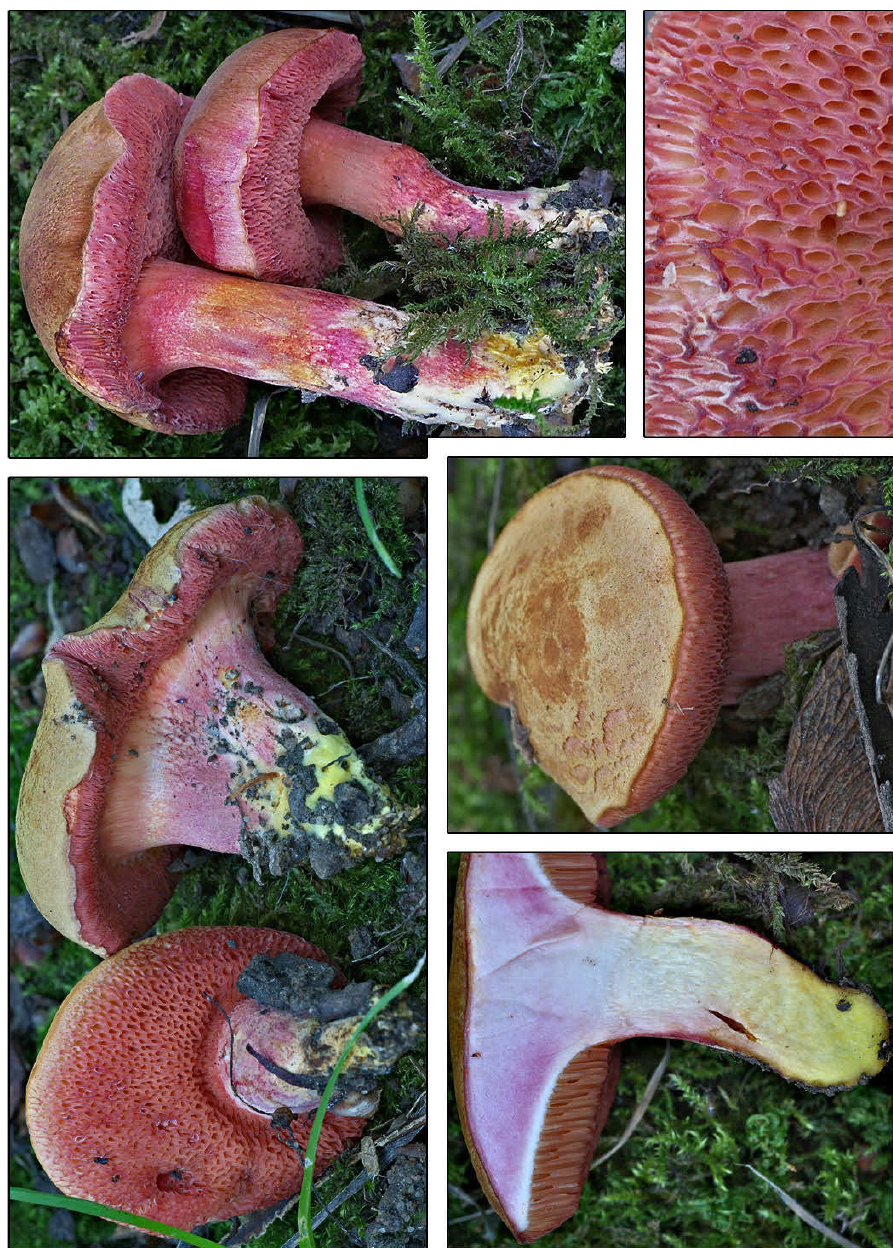
Fig. 3. Fruit-bodies of Chalciporus rubinus recorded in Wrocław (Phot. M. Halama,